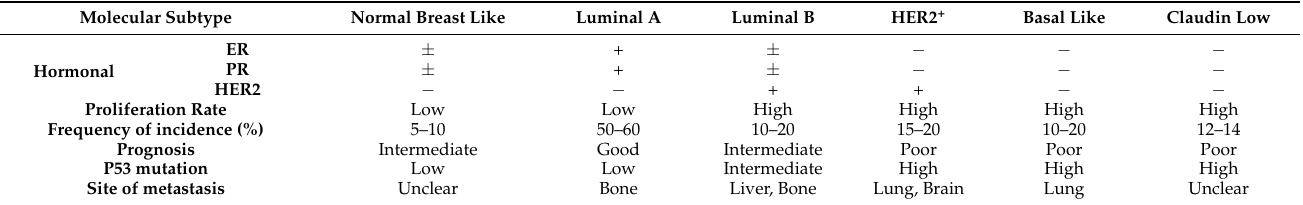
Table 1. Breast cancer subtypes based on